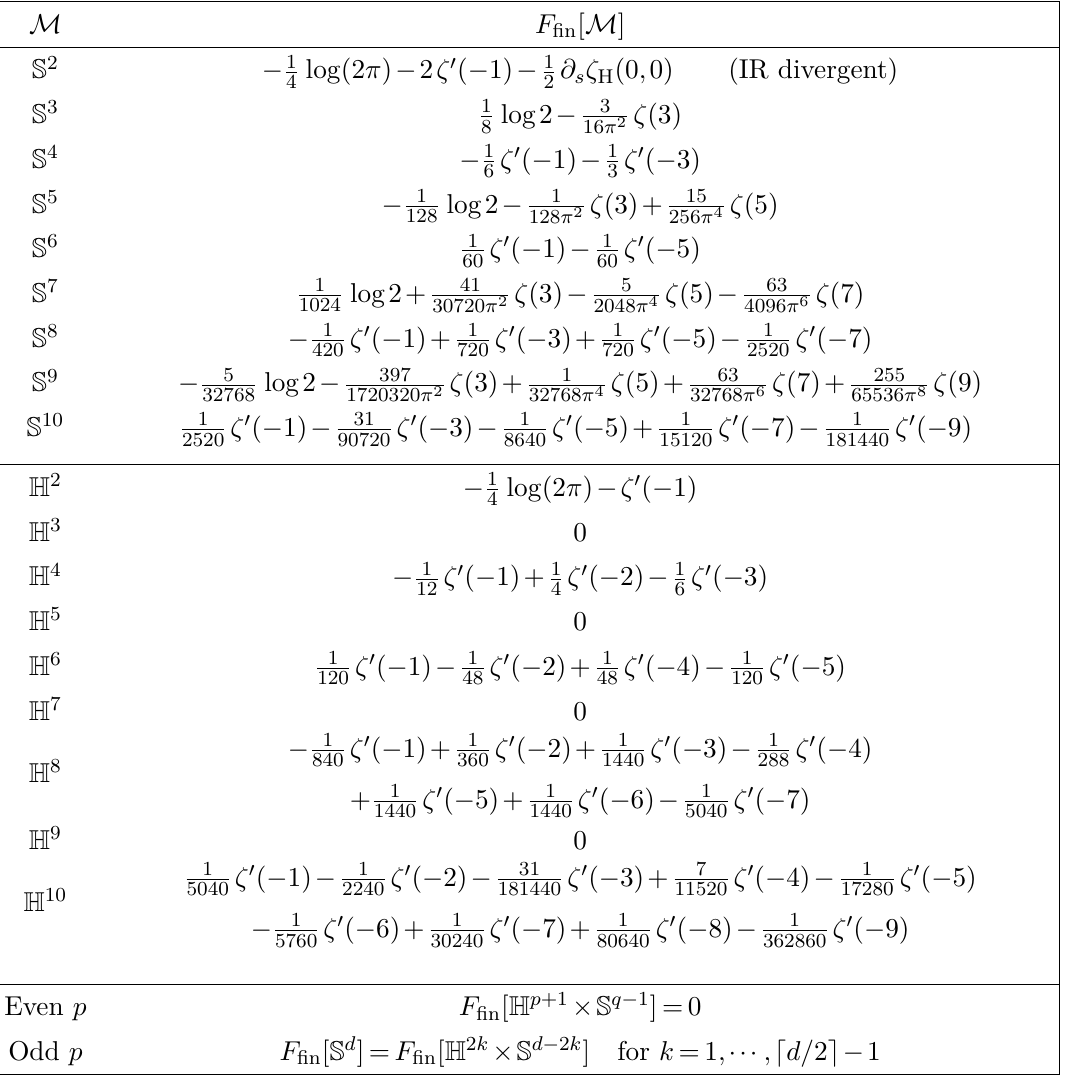
Table 3 . Table of the finite parts of F fin [ S d ] , F fin [ H d ] , and F fin [ H p +1 × S q − 1 ] with Dirichlet boundary